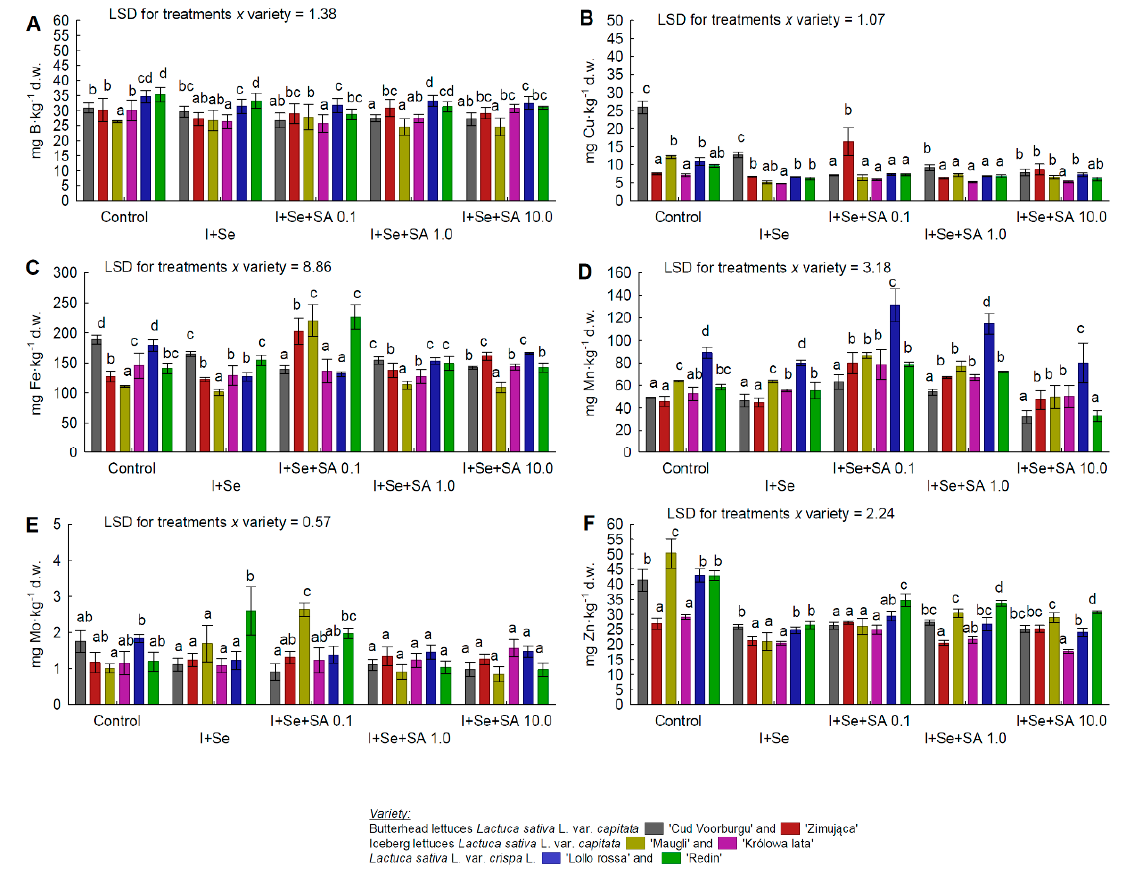
Figure 6. Concentrations of micronutrients: B ( A ), Cu ( B ), Fe ( C ), Mn ( D ), Mo ( E ), and Zn ( F ) in lettuce. Means for cultivars followed by the same letters separately for each treatment (type of nutrient solution) are not significantly different at p < 0.05. LSD for interaction “treatments × variety” at p < 0.05. Bars indicate standard errors ( n = 8). d.w. - dry matter weight.